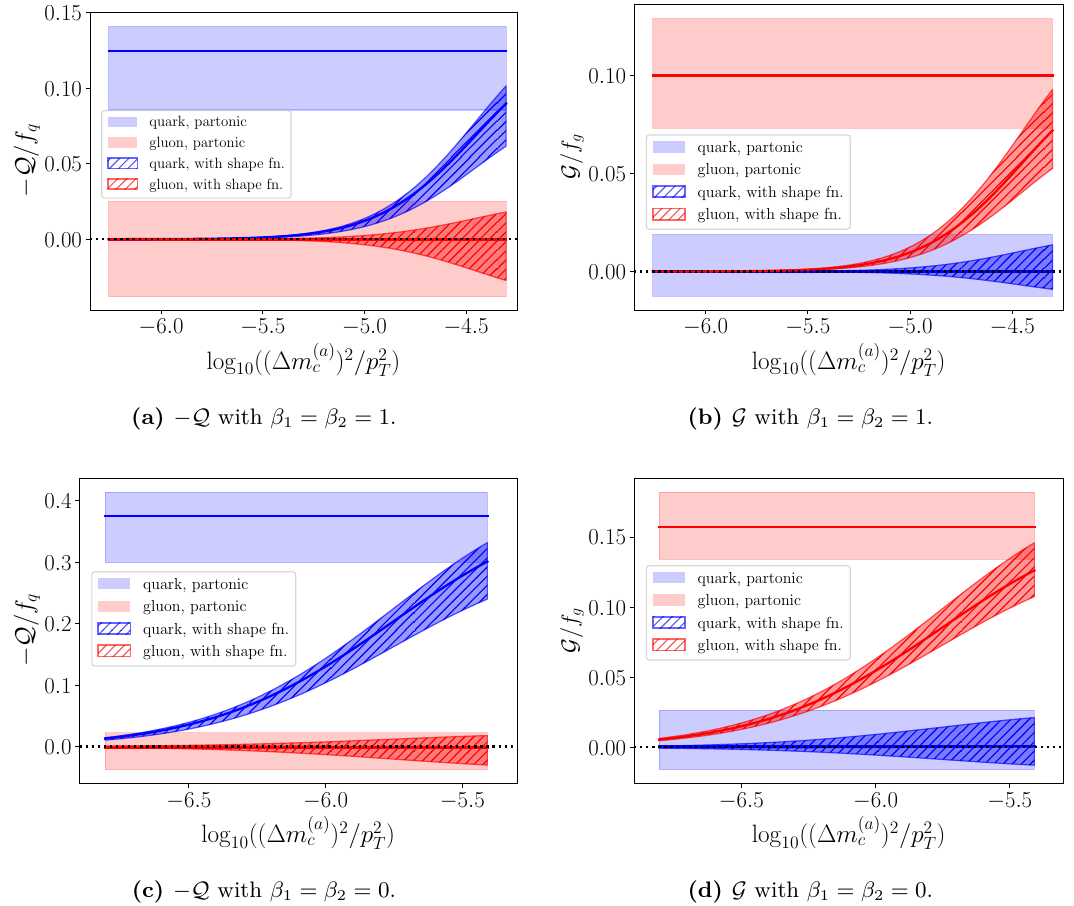
Figure 6. Pure quark (left column) and gluon (right column) observables with and without the shape functions included for the β 1 = β 2 = 1 (upper row) and β 1 = β 2 = 0 (lower row) cases. The uncertainty bands add contributions from the observable uncertainty and perturbative uncertainty in quadrature. The curves with the light shading for uncertainties do not include the shape function, whereas shape functions are included for the curves with the darker hatched